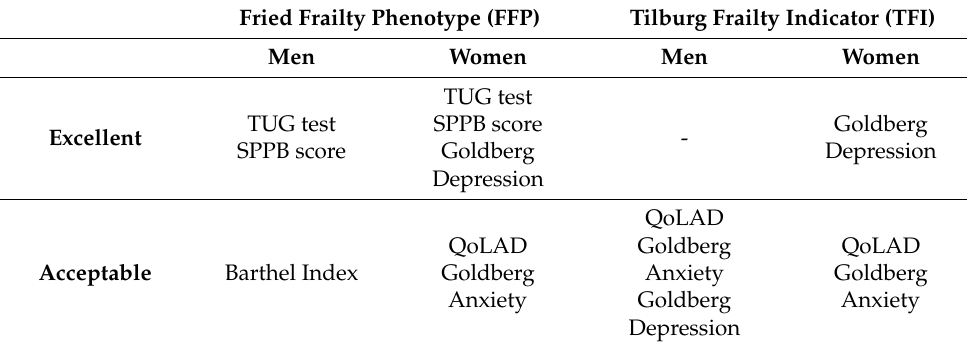
Table 4. Criterion validity for frailty